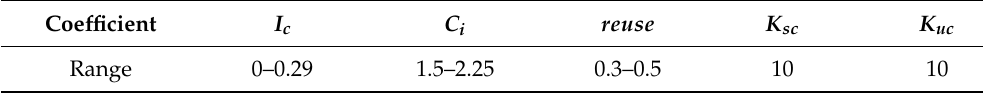
Figure 15. Simulated results of S3 (NCCS). Table 8. Estimated values of the coefficients in the coal mining